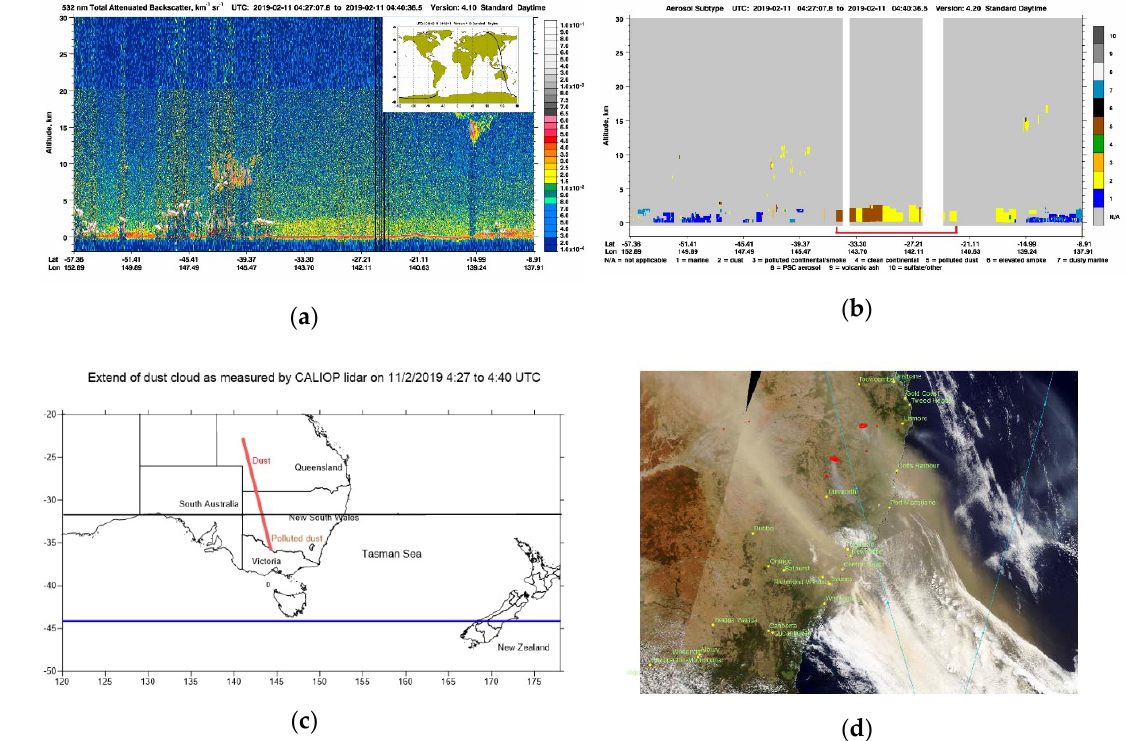
Figure 6. Extent of the dust cloud as detected by satellites: ( a ) LiDAR 532 nm total attenuated backscatter vertical structure on 11 February 2019 from 4:27 to 4:40 UTC with CALIPSO satellite path above central Australia; ( b ) aerosol subtype vertical profile as derived from CALIOP measurements. ( c ) Extent of the dust cloud (red line) as measured by CALIPSO satellite on 11 February 2019 4:27 to 4:40 UTC and cross sections of predicted PM 10 and wind profile (black and blue lines). ( d ) MODIS Terra satellite image of the dust event and wildfires in the New England area on 13 February 2019 and the locations of the main towns and cities in NSW.